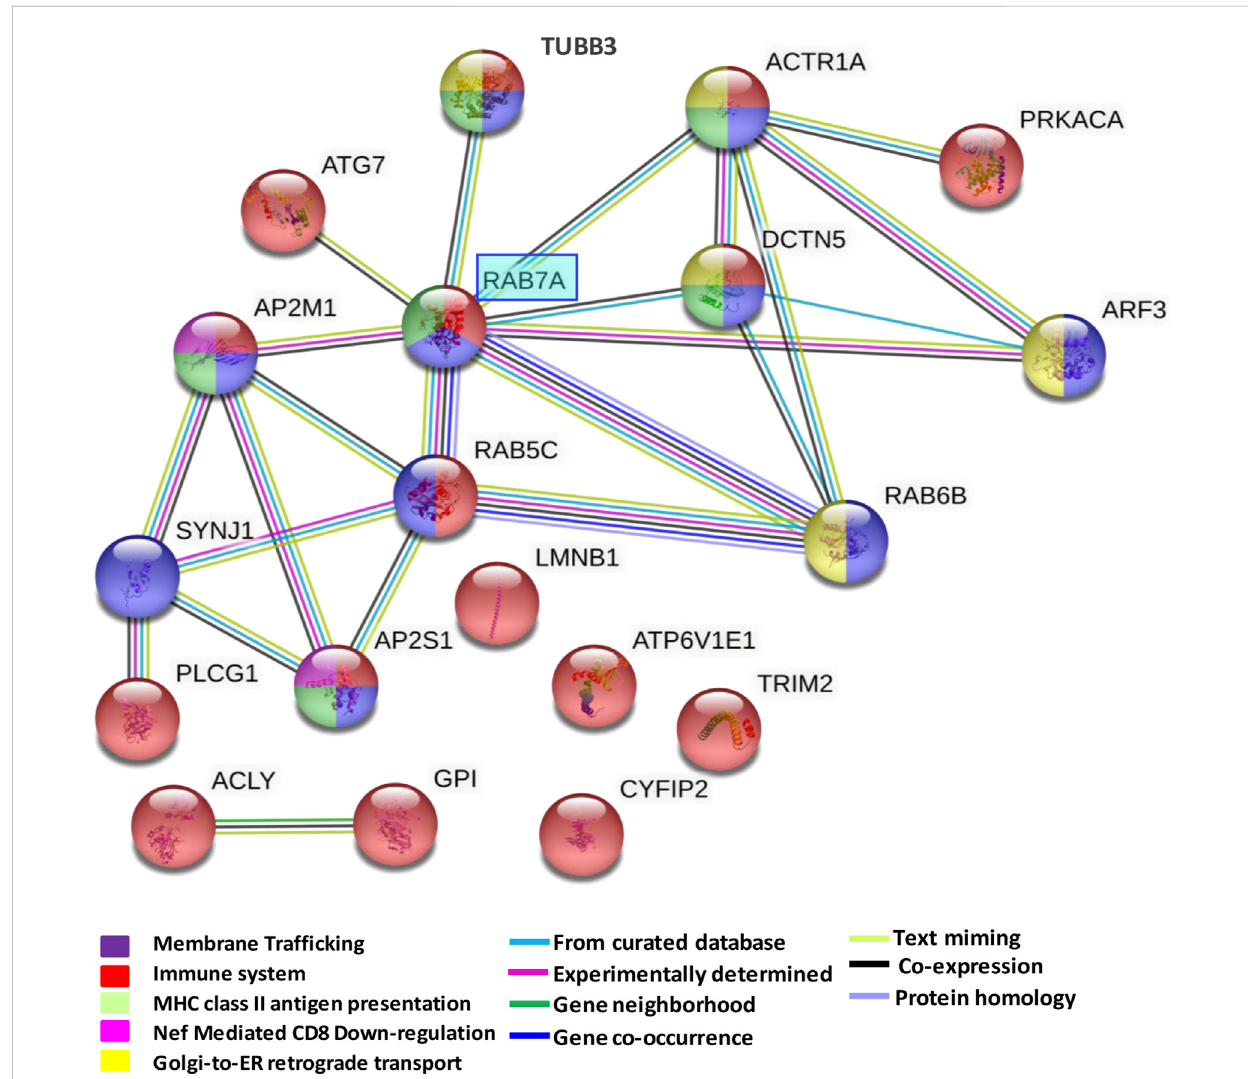
Network formed by altered pathways in the dorsolateral prefrontal cortex in schizophrenia. The protein-protein interaction network illustrates a mixedmodulewithinteractionsandoverlapsamongproteinsformedbydownregulatedpathways.Theinteractionoverviewshowshowproteinsoverlap in the different pathways. Each node represents a protein. The color denotes membership of a module. The colored edge (connections between nodes) represents the type of interaction between nodes. The network was generated using String